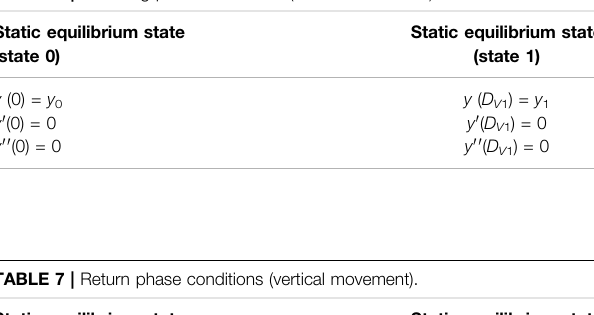
TABLE 6 | Reaching phase conditions (vertical movement).